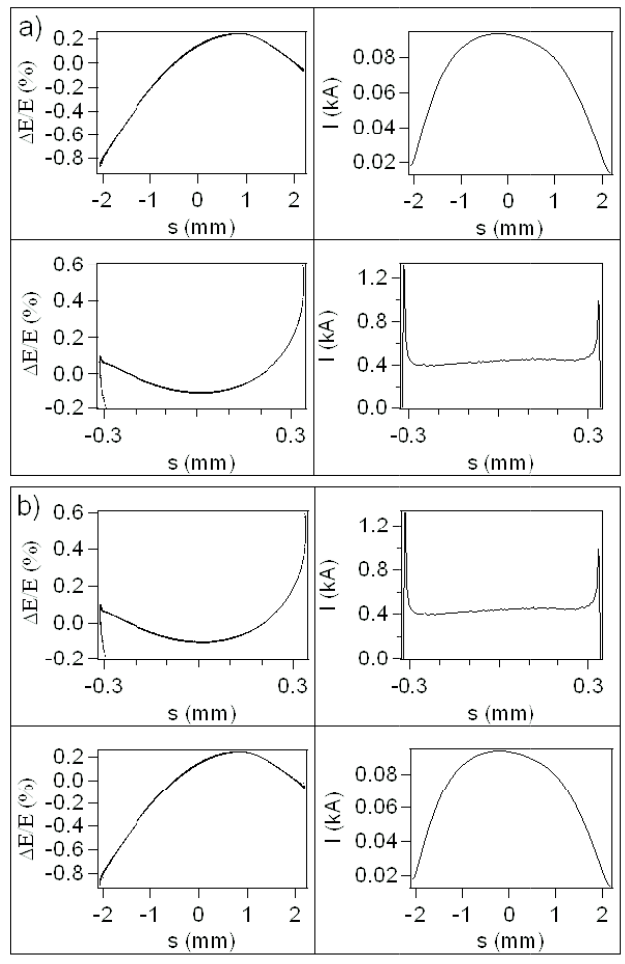
FIG. 2. Plot (a) shows forward particle tracking and plot (b) shows reverse particle tracking. Here and through the rest of the paper, the head electrons have negative s